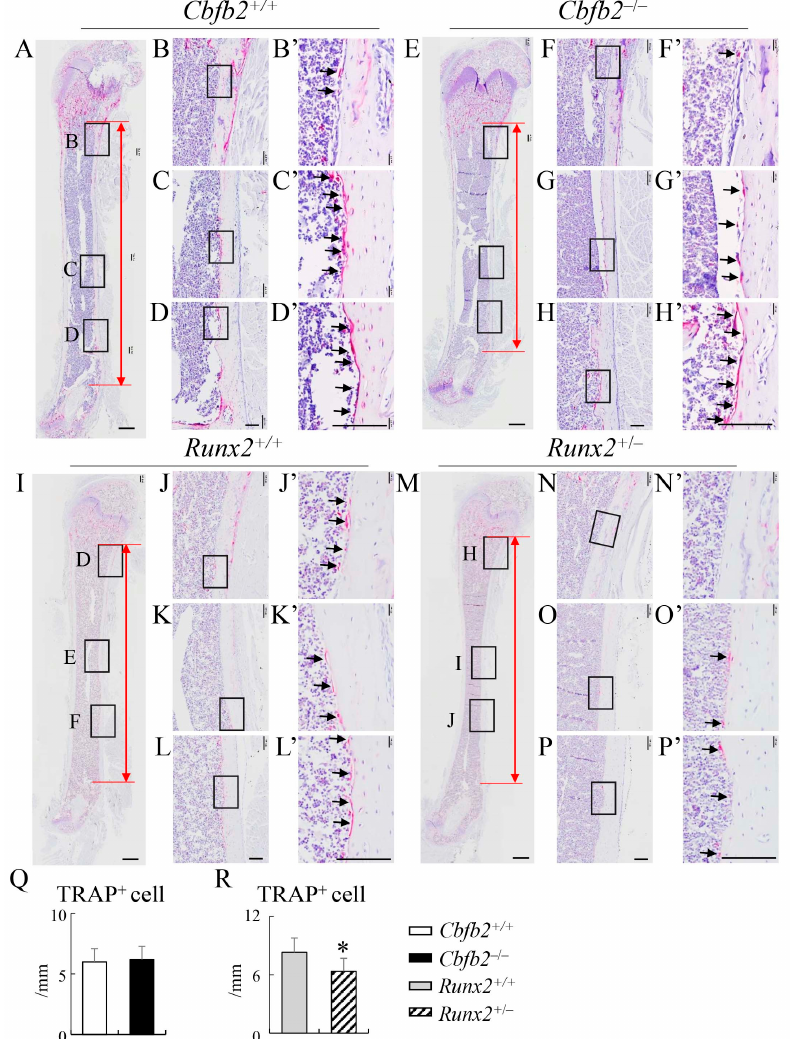
Figure 14. TRAP ‐ positive cells in the endosteum of femurs at 4 weeks of age. ( A – N ) TRAP staining of femoral sections in Cbfb2 +/+ ( A – D ), Cbfb2 –/– ( E – H ), Runx2 +/+ ( I – L ) and Runx2 +/– ( M – P ) mice. The boxed regions in ( A , E , I , M ) are magnified in ( B – D ), ( F – H ), ( J – L ) and ( N – P ), respectively, and the boxed regions in ( B – D ), ( F – H ), ( J – L ) and ( N – P ) are magnified in ( B’ – D’ ), ( F’ – H’ ), ( J’ – L’ ) and ( N’ – P’ ), respectively. Black arrows indicate the TRAP ‐ positive cells. Red lines show the area for counting in the endosteum. Scale bars: 500 μ m ( A , E , I , M ) and 100 μ m ( B – D , F – H , J – L , N – P , B’ – D’ , F’ – H’ , J’ – L’ , N’ – P’ ). ( Q , R ) The number of TRAP ‐ positive cells in Cbfb2 +/+ and Cbfb2 –/– mice ( Q ) and Runx2 +/+ and Runx2 +/– mice ( R ). Data are shown as the mean ± SD. * p < 0.05. The number of mice analyzed: Cbfb2 +/+ and Cbfb2 –/– , n = 6; Runx2 +/+ and Runx2 +/– , n = 7. 2.7. Expressions of the Genes Related to Osteoblast and Osteoclast Differentiation, RUNX Family Genes and Cbfb Real ‐ time reverse transcription ‐ polymerase chain reaction (RT ‐ PCR) was performed using RNA from the tibiae and vertebrae at 4 weeks of age (Figure 15A,B). In Cbfb2 –/– tib ‐ iae, the expressions of Sp7 , Alpl , Col1a1 , Tnfsf11 , Cbfb1 , Cbfb2 and Cbfb1+2 and the ratio of